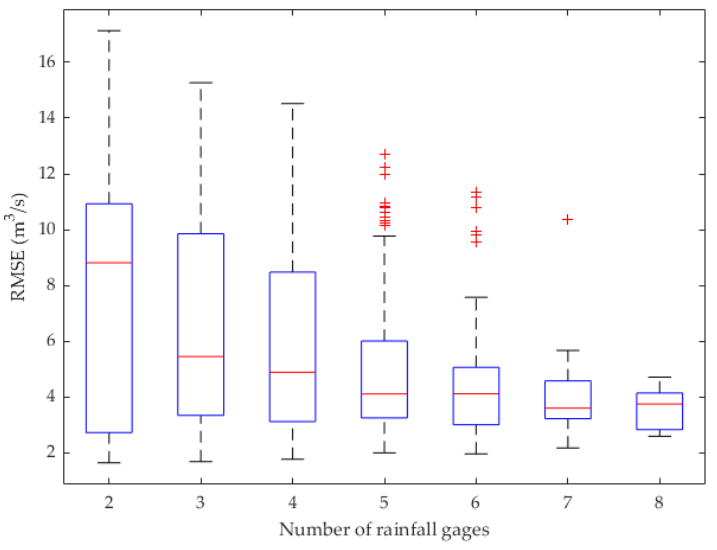
Figure 11. Box plot of model error (Root Mean Square Error (RMSE)) and the number of rainfall gauges.